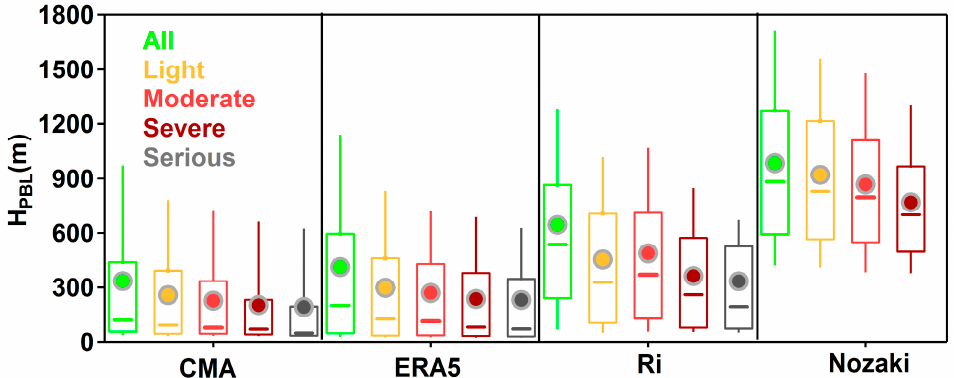
Figure 3. Statistics of the results of the four BLH methods for all and different levels of PM 2.5 pollution processes from 2017 to 2021. (H PBL : BLH; all: 52 PM 2.5 pollution processes; Light: light pollution processes; Moderate: moderate pollution processes; Severe: severe pollution processes; Serious: serious pollution processes; solid circle are mean values, short horizontal lines from top to bottom are 75th, median and 25th quartiles respectively, vertical lines indicate 90th and 10th quartiles). The mean BLH values of different pollution processes calculated by four